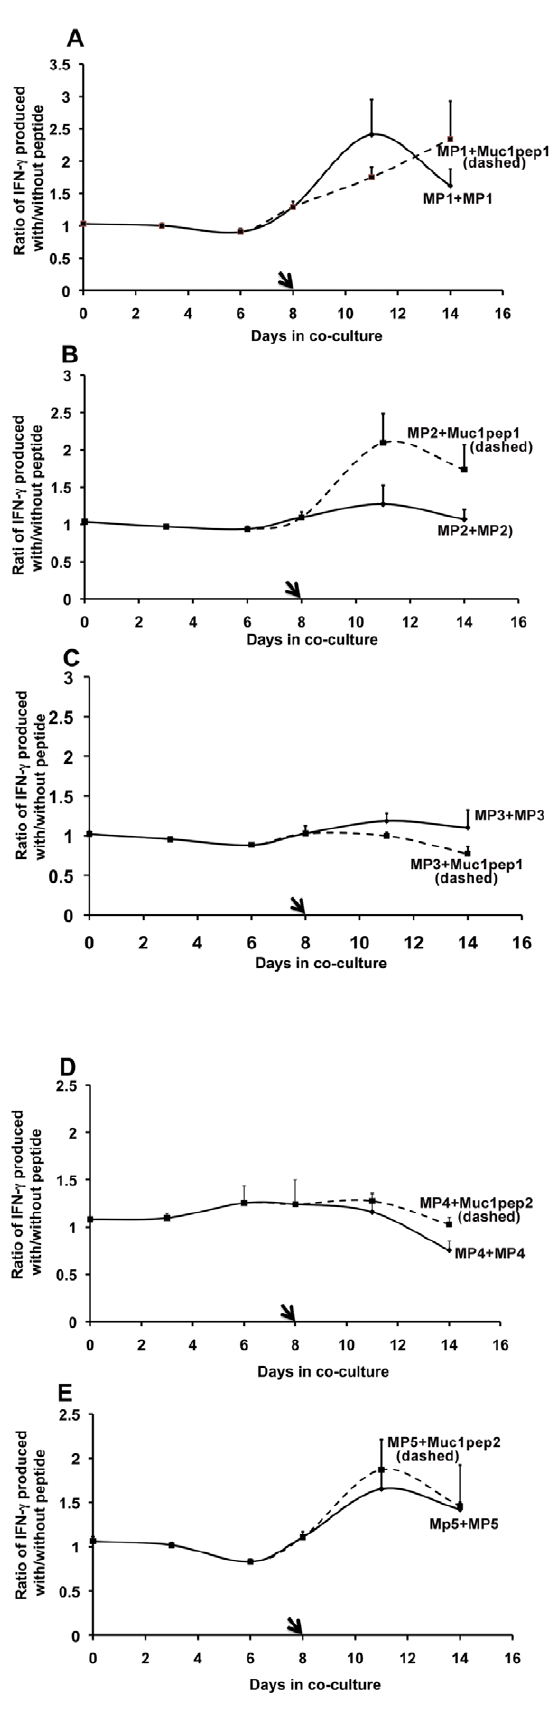
Figure 4. Cross-stimulation of CD14- cells by Mimic and native MUC1 peptides. CD14 2 cells were incubated with DCs loaded with mimic peptides and then restimulated with a fresh batch of DCs loaded with either the same peptide or the original MUC1 core peptides (Fig. 1). T-cell stimulation was monitored by quantifying the amount of IFN- c released into the medium. The IFN- c levels were normalized to the levels produced following incubation with DCs that had no peptides loaded. Error bars represent the normalized % error from two independent experiments. A. CD14 2 cells stimulated with MP1 and then re-stimulated on day 8 with MP1 (solid line) or cross-stimulated with MUC1pep1 (dashed line). B. CD14 2 cells stimulated with MP2 and then re-stimulated on day 8 with MP2 (solid line) or cross-stimulated with MUC1pep1 (dashed line). C. CD14 2 cells stimulated with MP3 and on day 8, re-stimulated with MP3 (solid line) or cross-stimulated with MUC1pep1 (dashed line). D. CD14 2 cells stimulated with MP4 and on day 8 re-stimulated with MP4 (solid line) or cross-stimulated with MUC1pep2 (dashed line). E. CD14 2 cells stimulated with MP5 and on day 8, re-stimulated with MP5 (solid line) or cross-stimulated with